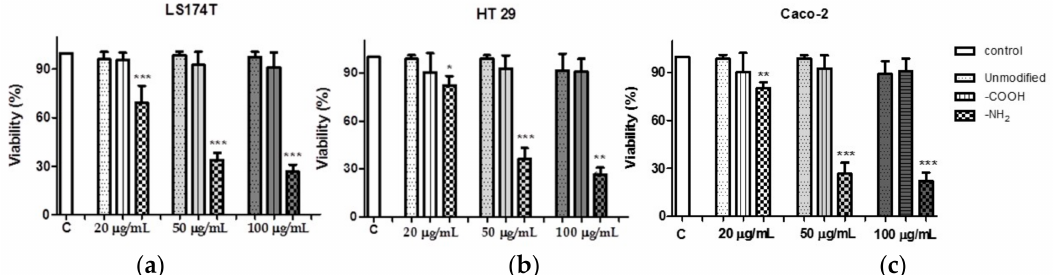
Figure 4. Effect of polystyrene nanoparticles on ( a ) LS174T; ( b ) HT-29; and ( c ) Caco-2 cell viability. Data are presented as mean ± SD of n ≥ 3. One-way ANOVA followed by Tukey–Kramer multiple